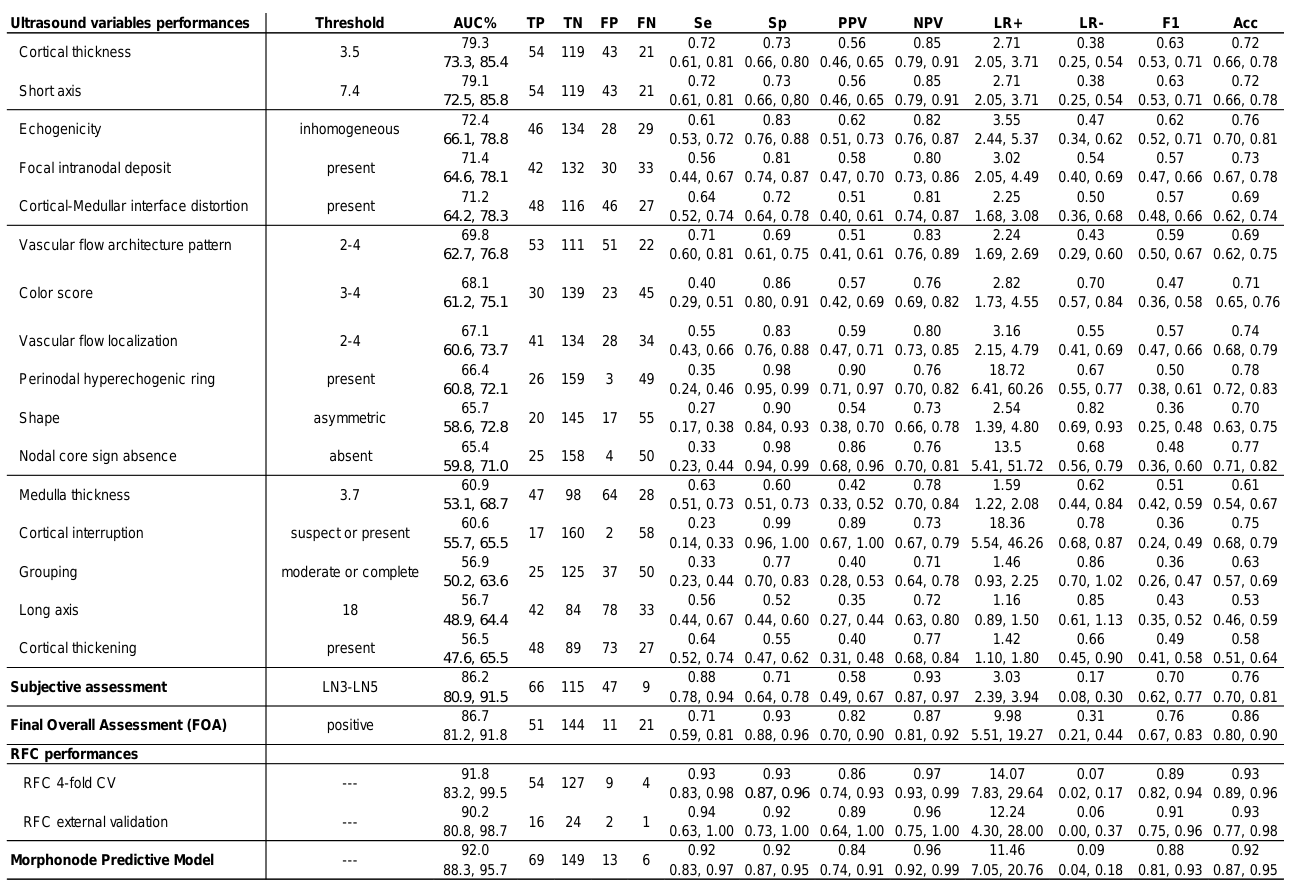
Figure 2. Predictive performances of ultrasound features, subjective assessment and Morphonode – RFC. Ultrasound variables are grouped in four blocks according to the Area Under the ROC Curve: AUC > 75% (first), AUC > 70% (second), AUC > 65% (third), and AUC <= 65% (fourth). The optimal cut-point value (threshold) was defined by a max-Sensitivity/max-Specificity criterion. AUCs, performance indices, and their 95% confidence intervals are reported. Performance indices acronyms for ultrasound variables, subjective assessment, and Morphonode–RFC are the following: TP, True Positives; TN, True Negatives; FP, False Positives; FN, False Negatives; Se, Sensitivity; Sp, Specificity; PPV, Positive Predictive Value (Precision); NPV, Negative Predictive Value; LR+, Positive Likelihood Ratio, LR − , Negative Likelihood Ratio; F1, F1 score; Acc, Accuracy. The F1 score is defined as the harmonic mean between precision (PPV) and sensitivity (Se), thus penalizing huge differences between sensitivity and specificity. This provides a more reliable predictive accuracy measure than Acc = (TP + TN)/(TP + TN + FP + FN).